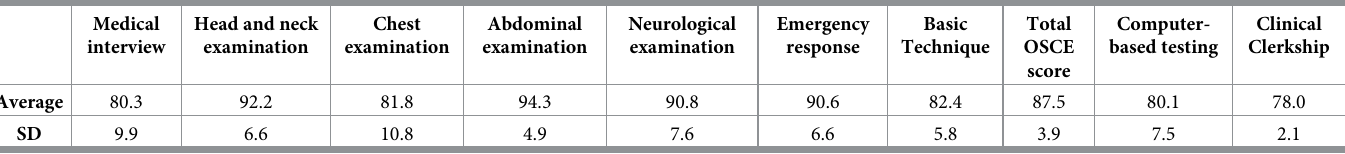
Table 1. Scores for objective structured clinical examination (OSCE), computer-based testing (CBT), and clinical clerkship (CC). Medical